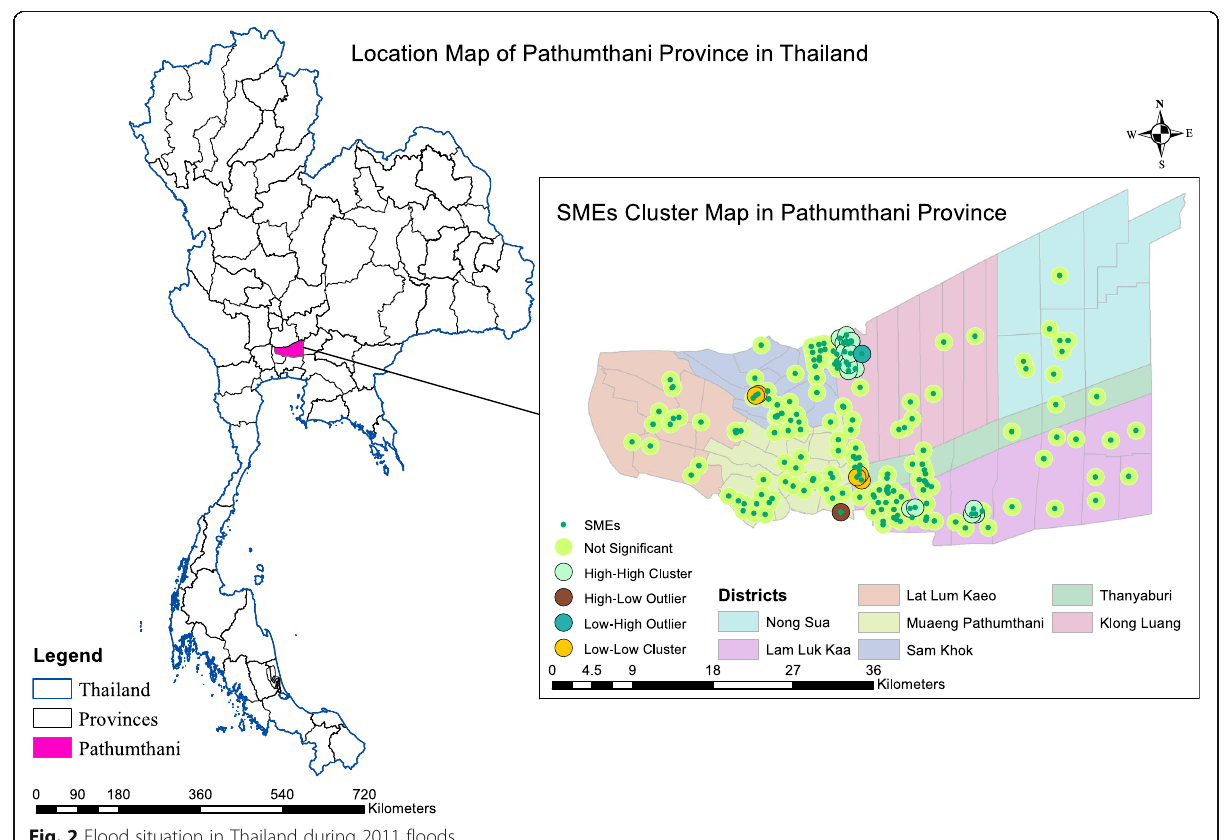
Fig. 2 Flood situation in Thailand during 2011